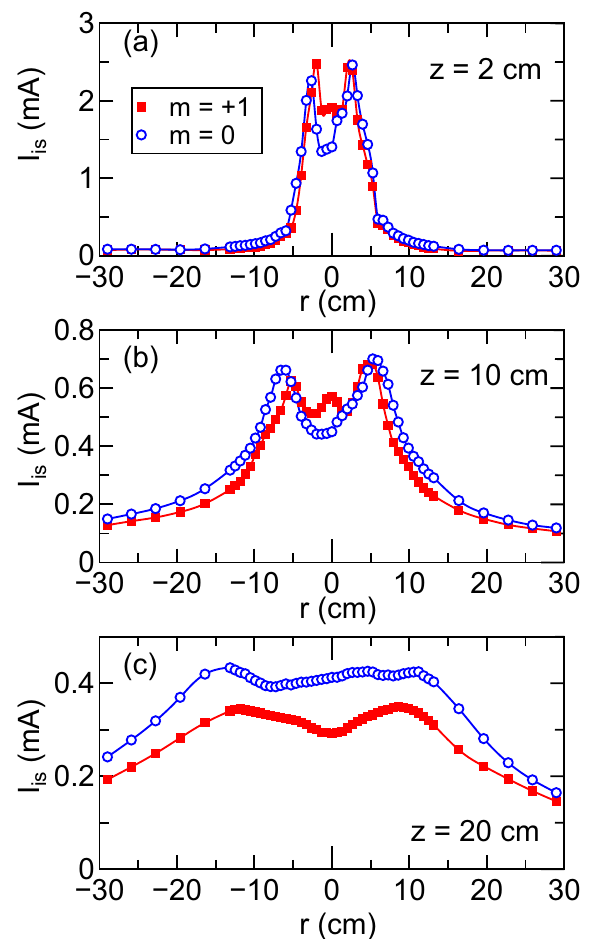
1 mode helical (filled squares) and Figure 7. Radial profiles of the ion saturation current I is for the m = + 0 mode loop (open circles) antennas at ( a ) z 2 cm, ( b ) z 10 cm, and ( c ) z 20 cm, where the data are m = = = = 1 mode antenna in ( b ) shows the center peak of I extracted from Fig. 6. The profile for the m is in addition = + 0 mode case is slightly to the peripheral peak. The measured profiles imply that the plasma radius for the m = 0 mode case at z 20 cm 1 mode case. Furthermore, the values of I larger than that for the m is for the m = = = + 1 mode case as seen in ( c is about 30% larger than that for the m = +